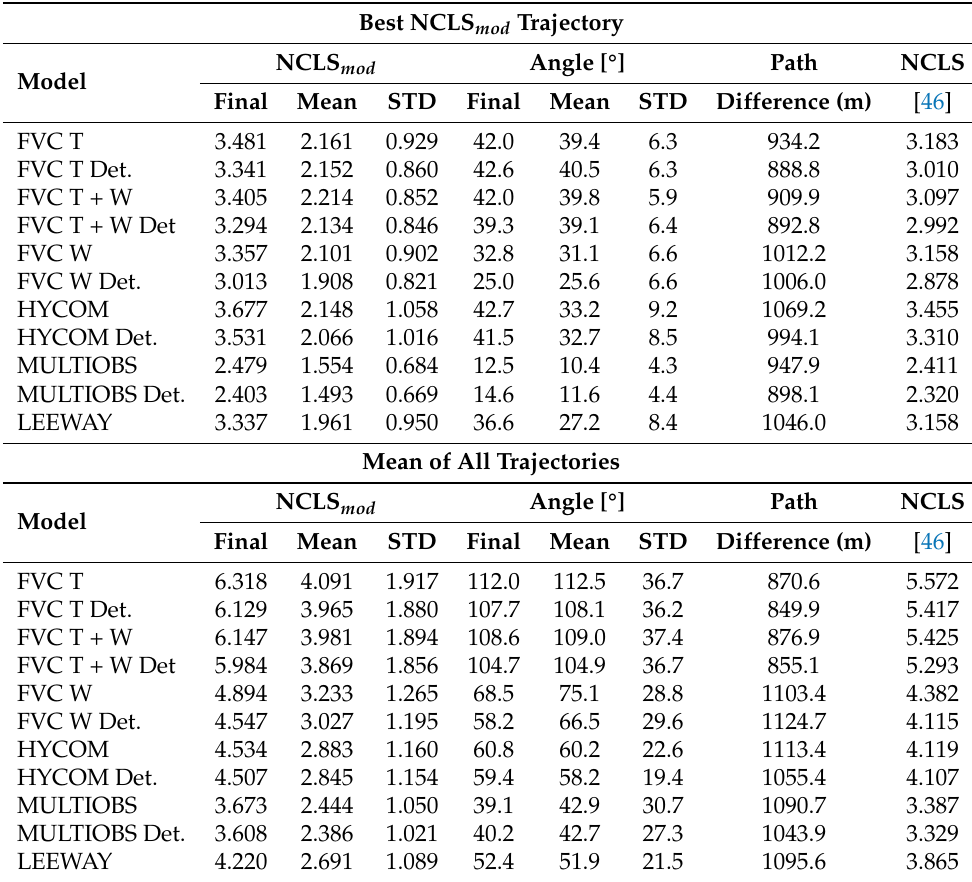
Table A2. Performance statistic values for each model and scenario used for 14 September